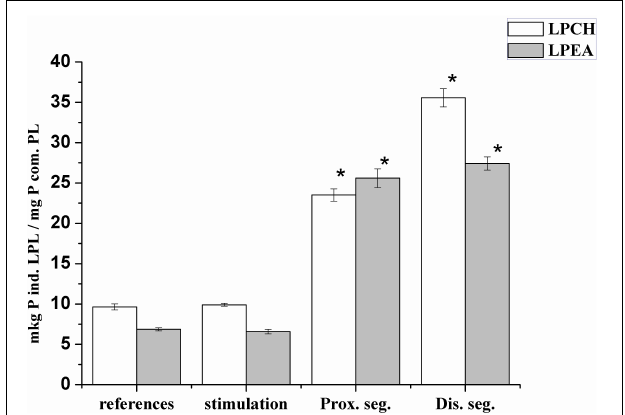
FIGURE 3 | Changes in the levels of lysophosphatidylcholine (LPCH) and lysophosphatidylethanolamine (LPEA) in the myelin rat nerve during stimulation and after nerve cutting; ∗ the significance of the difference in relation to control, p < 0.05.